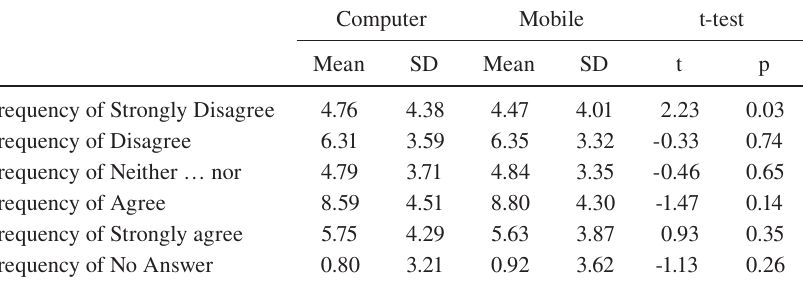
T-tests for the estimation of mode (computer vs mobile)